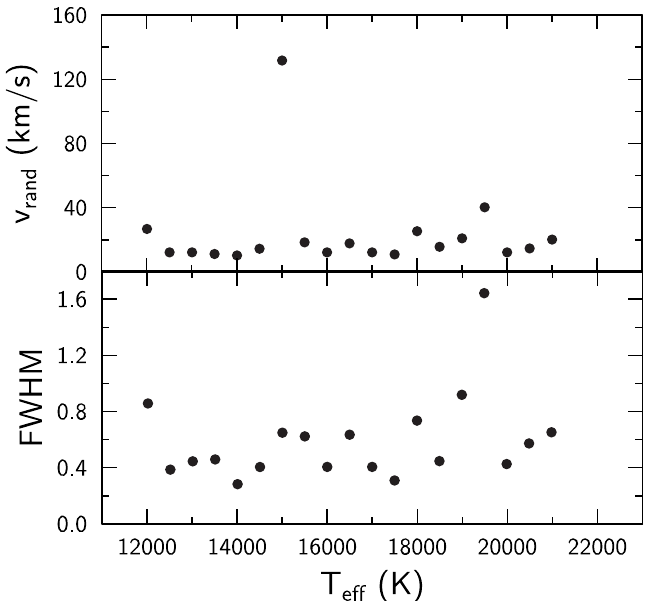
Fig. 3. Random velocities (top) and the FWHM (bottom) of the Mg II resonance lines vs. T eff